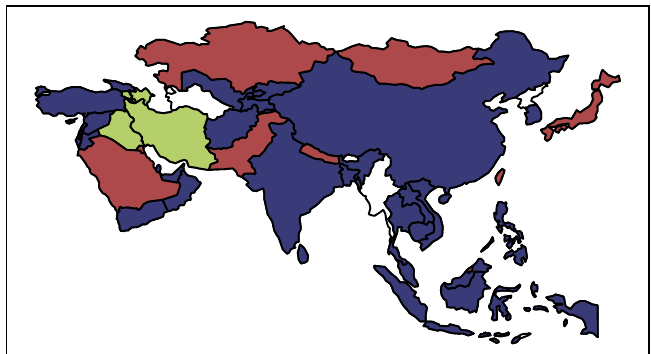
Figure 11. A map portraying the income groups of the most frequent collaborators of Asian nations. Nations colored in blue most frequently collaborate with high-income group nation, nations in green most frequently collaborate with upper-middle-income group nations, nations colored in red most frequently collaborate with lower-middle-income group nations, and nations colored in white did not have publications in the data set.